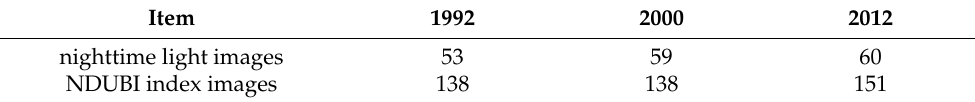
Table 2. The optimal segmentation thresholds for nighttime light images and NDUBI index images.